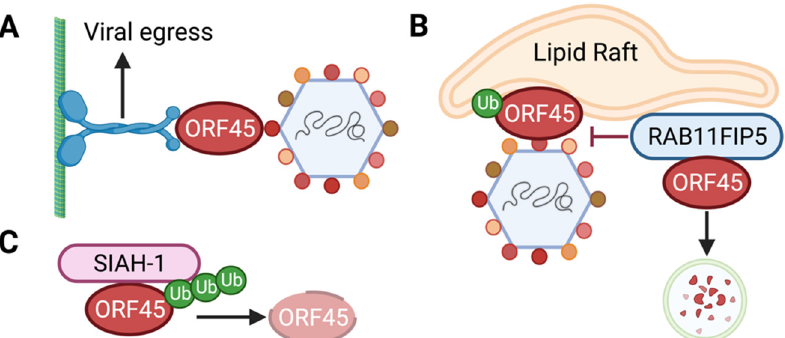
Figure 2. ORF45 role in the viral life cycle. ( A ) ORF45 associates with the cargo-binding domain of the KIF3A subunit of kinesin-2, which mediates the association of the viral capsid-tegument complex with microtubules, promoting viral egress. ( B ) ORF45, which is mono-ubiquitylated at lysine 297, mediates association of the viral capsid-tegument complex with lipid rafts targeted to the trans- Golgi network for eventual viral envelopment and egress. Host RAB11 family-interacting protein RAB11FIP5 interferes with ORF45 targeting to lipid rafts by interacting with ORF45 and promoting its lysosomal degradation, thereby inhibiting the endosomal trafficking of viral particles. ( C ) The SIAH-1 E3 ubiquitin ligase interacts with ORF45 leading to ORF45 ubiquitylation and degradation.